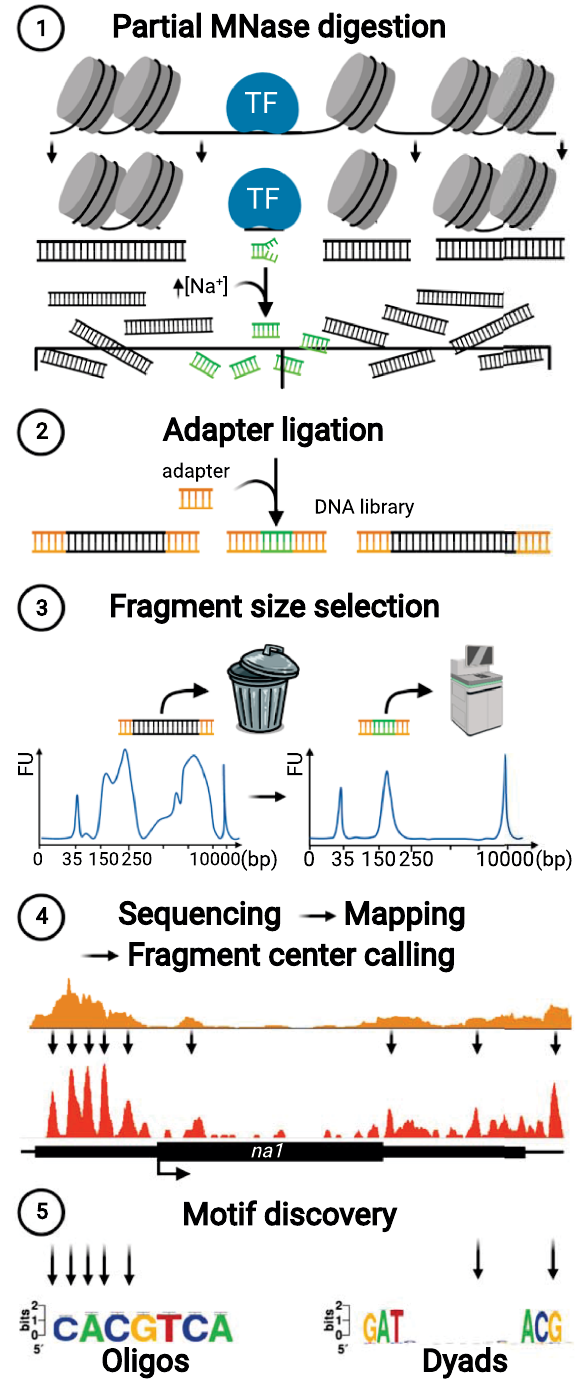
Fig 1. Overview of MOA-seq method. Flowchart summarizes the five key steps that allow for genome-wide, high- throughput and -resolution transcription factor footprinting and candidate motif discovery. Crosslinked, purified nuclei are subjected to light digestion with MNase (Step 1), producing fragments that range from large nucleosome- sized (grey dsDNA) to small, protein-bound (green dsDNA) DNA-footprints. High salt is included during DNA purification and adapter ligation (Step 2) is performed prior to size selection (Step 3). These steps serve to increase the recovery of desired small footprint fragments while efficiently eliminating unwanted nucleosome-sized fragments,